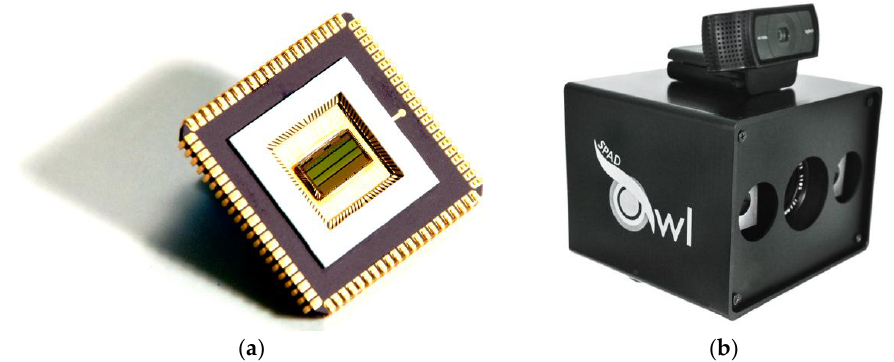
Figure 5. ( a ) Photograph of the CMOS SPAD-based flash LiDAR sensor with 192 × 2 pixel in a CQFJ84 package; ( b ) Flash LiDAR camera demonstrator “Owl” developed at Fraunhofer IMS. package; ( b ) Flash LiDAR camera demonstrator “Owl” developed at Fraunhofer